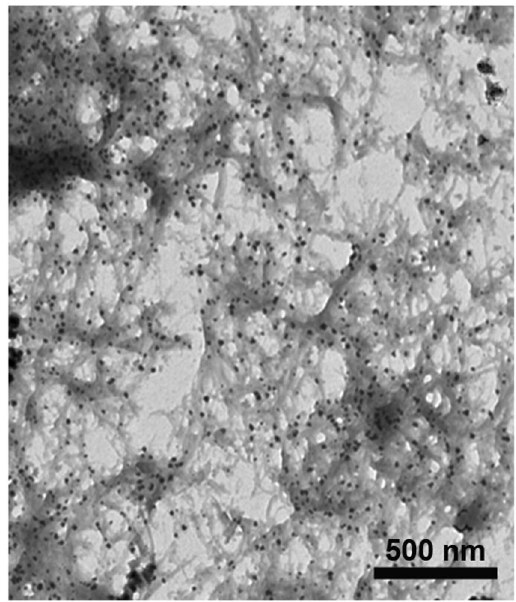
Figure 1. TEM images of poly(thionine)-Au